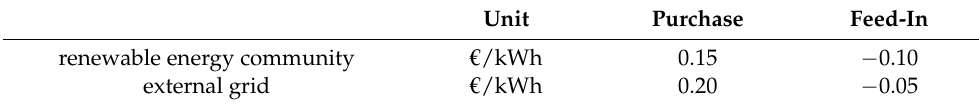
Table 1. Prices for energy purchase from and feed-in into the renewable energy community and the external grid based on electricity prices and regulatory incentive models for local renewable energy communities in Austria [12,28]. Unit Purchase Feed-In renewable energy community external